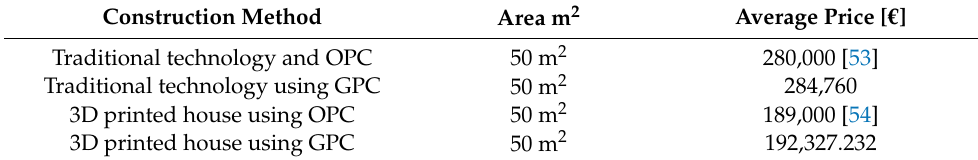
Table 12. Estimated cost comparison between traditional and 3D printed house. Construction